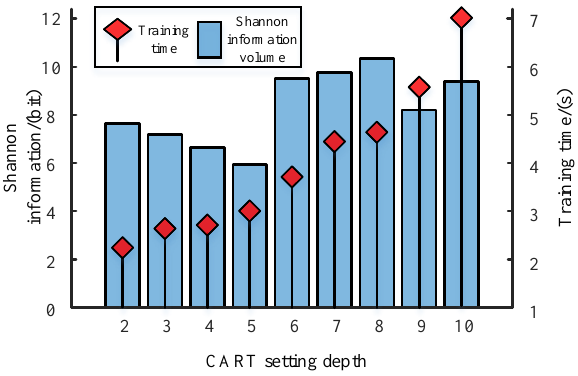
Figure A3. Comparison of different depths of CART.